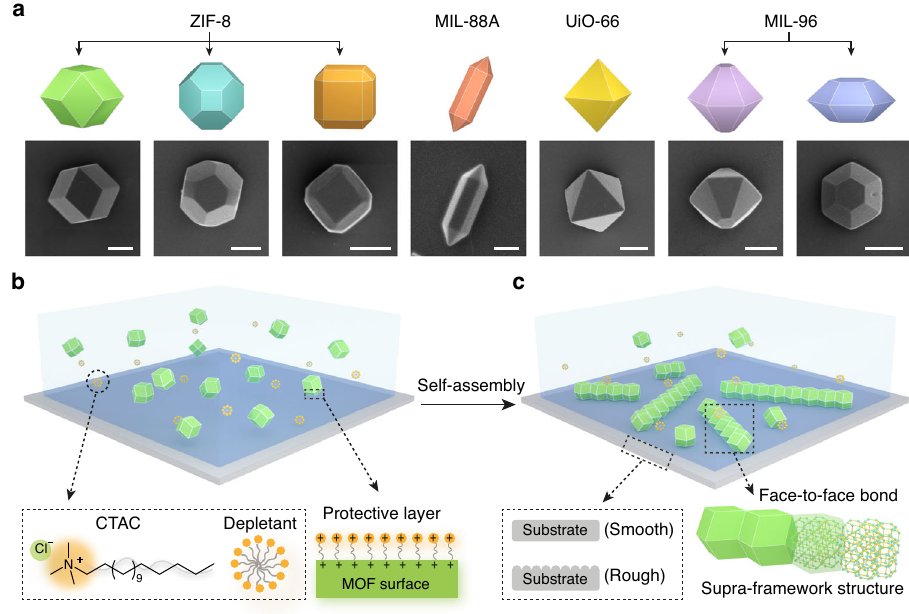
Fig. 1 Strategy for assembling MOF microcrystals. a Cartoons (top panel) and scanning electron micrographs (SEM, bottom panel) showing microcrystals of common MOF families. Scale bars: 500 nm. b , c Schematics showing the self-assembly of MOF microcrystals via depletion interaction induced by ionic amphiphiles (e.g., cetyltrimethylammonium chloride, CTAC). Particles of a representative shape (rhombic dodecahedral, RD, green) are well dispersed in aqueous solution (light blue, b ) and then assembled into low-dimensional MOF colloidal superstructures (or supra-framework structures) by establishing shape-directed face-to-face bonds ( c ). The molecular structure of CTAC, cartoon of the CTAC micelle as depletant, and illustration of protective surface layer are shown. The substrate of assembly (gray) with a smooth or rough surface in fl uences the particle orientation and assembly